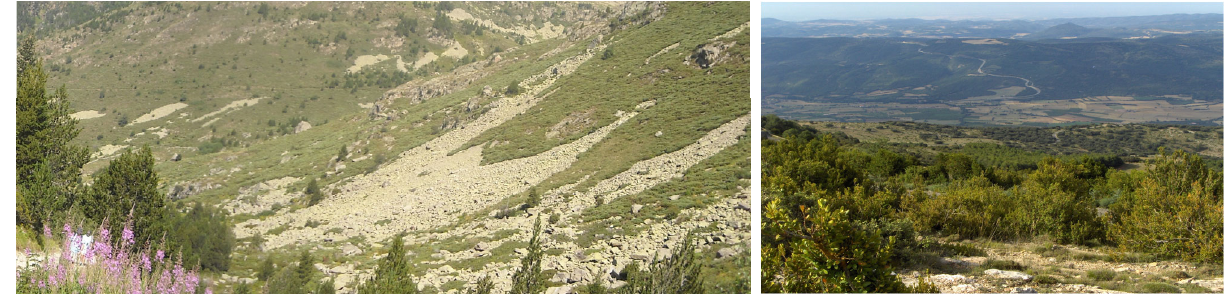
Figure 2. Shrubby formations, on the left Pyrenean formations–A area (prostrate for ‐ mations in the midst of grasslands and rocky areas); on the right pre ‐ Pyrenean shrubs–B area. Au ‐ thors’ pictures.